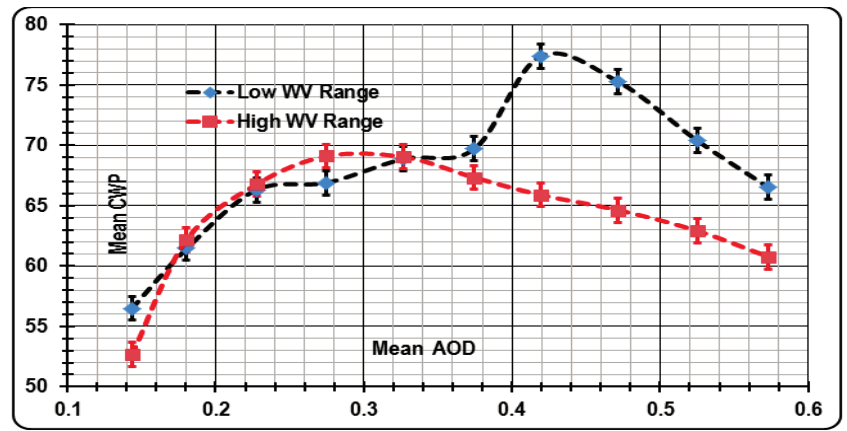
Figure 9. Response of cloud water path (CWP) to increasing aerosol optical depth (AOD) in low and high atmospheric WV environments for NAADR_Land.